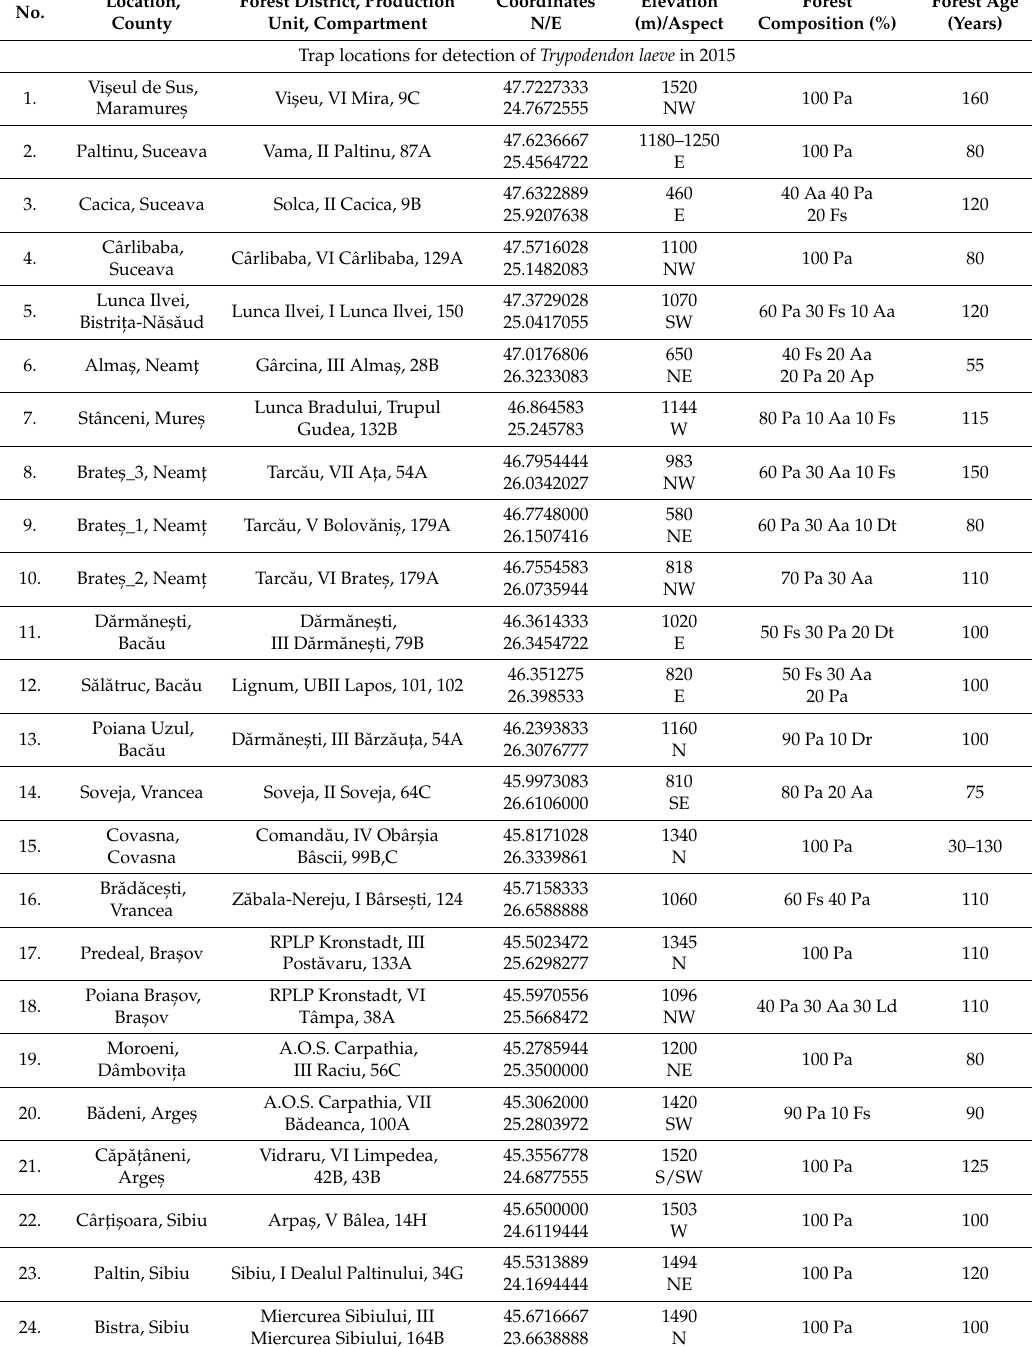
Table 1. Location of study sites and tree stand characteristics where pheromone traps were set